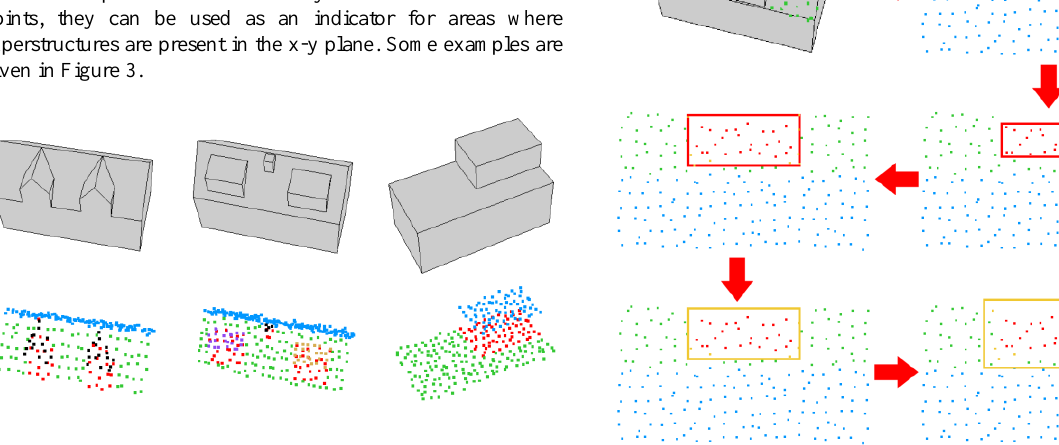
Figure 5. From top to bottom: building overlaid with surface points and the CCA result; bounding rectangles (virtual points); bounding rectangles (surface